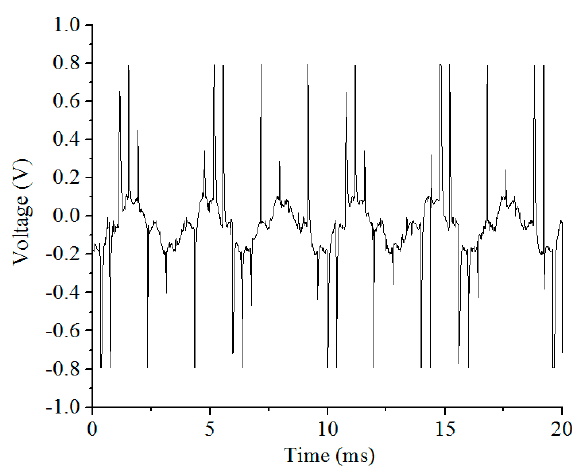
Figure 2. Test of driving interference for micro gyroscope with ball-disc rotor.